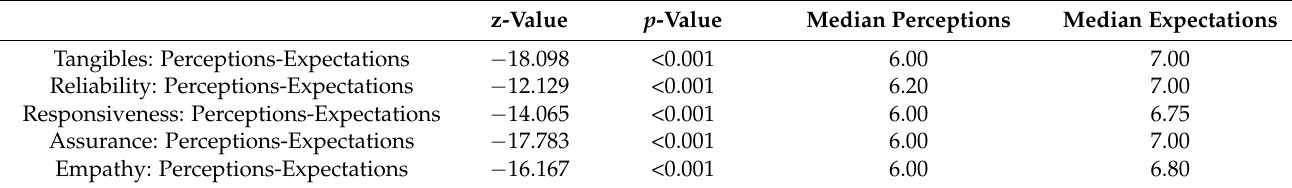
Table 6. Summary of differences between Expectations—Perceptions for the SERVQUAL dimensions (Wilcoxon matched pairs signed ranks test).